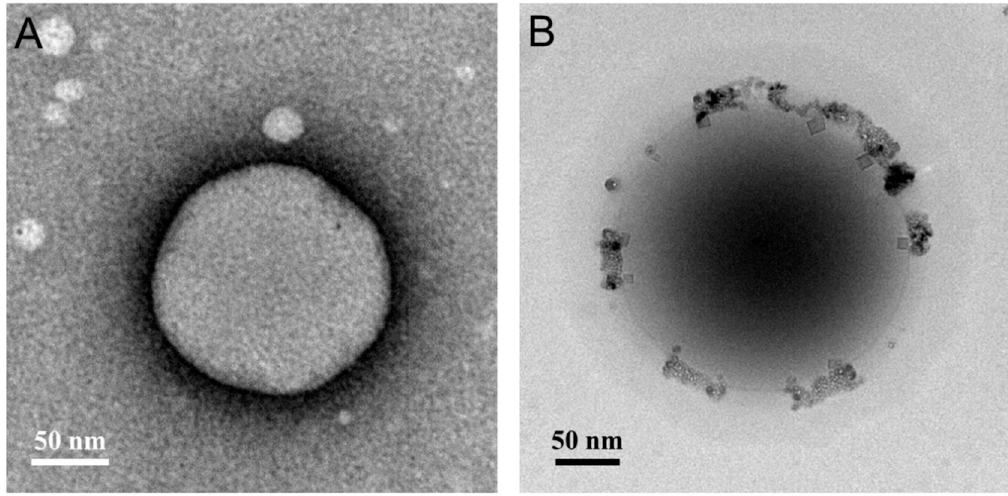
Figure 1. TEM characterization of NPs. ( A ) TEM image of G/A NP; ( B ) TEM image of DG/FA NP.